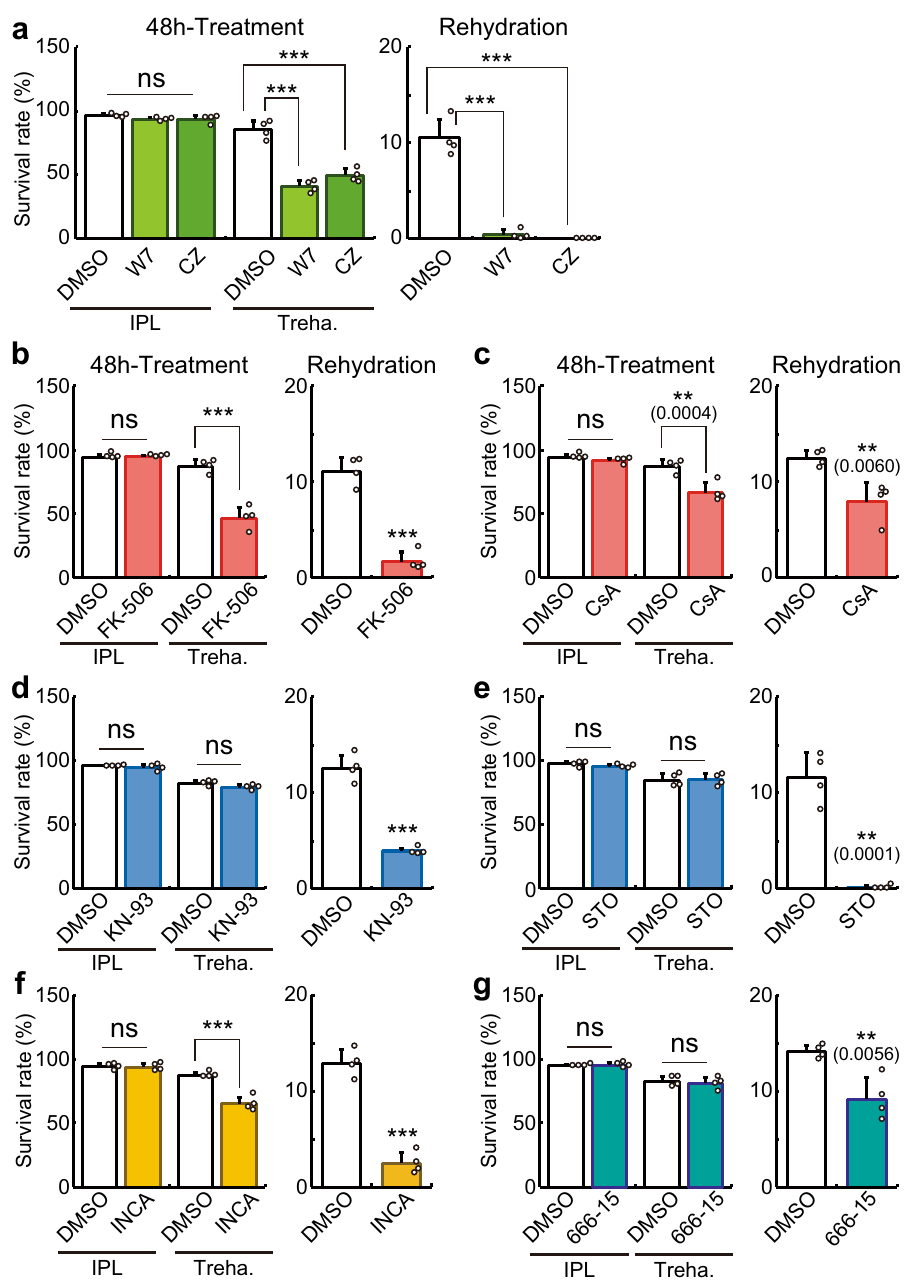
Figure 4. Contribution of calcium signaling pathways to desiccation tolerance in Pv11 cells. ( a – g ) Pv11 cells were treated with CaM inhibitors (W7 and calmidazolium; ( a ), CaN inhibitors (FK-506 and cyclosporine A; ( b ) and ( c ), respectively), CaMK inhibitors (KN-93 and STO-609; ( d ) and ( e ), respectively), an NFAT inhibitor (INCA-6; f ) and a CREB inhibitor (666–15; g ) and survival rates were analyzed during IPL-41/ trehalose treatment or after desiccation-rehydration treatment. Values are expressed as mean ± SD; n = 4 in each group. Treatments were performed at the following concentrations: W7, 100 µM; calmidazolium, 7.5 µM; FK-506, 40 µM; cyclosporin A, 160 nM; KN-93, 30 µM; STO-609, 20 µM; INCA-6, 30 µM; and 666–15, 20 µM. ***p < 0.0001, **p < 0.01 (actual p-values are shown within